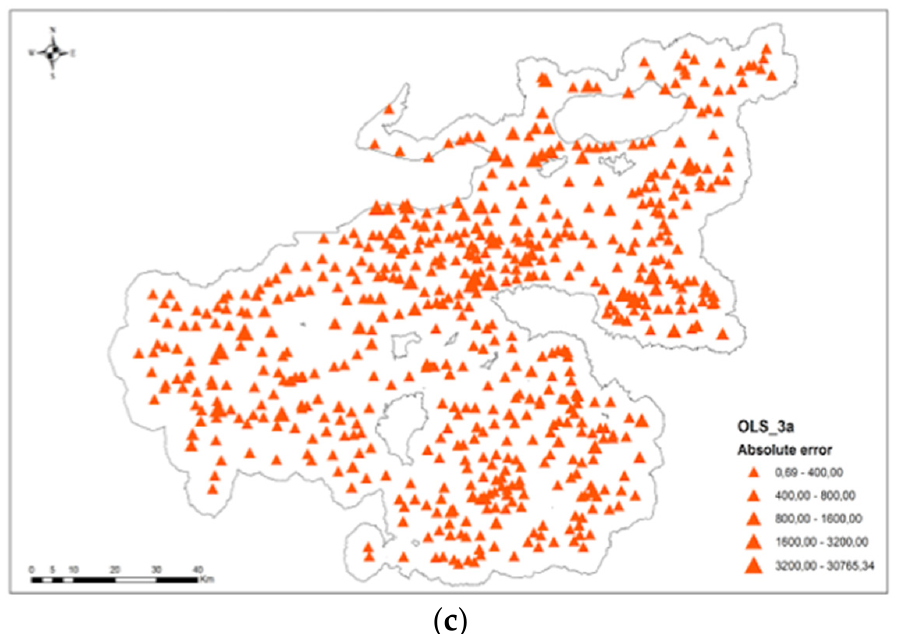
Figure 9. Comparison of absolute errors across different OLS models including ( a ) OLS_1a; ( b ) OLS_2a; and ( c ) OLS_3.